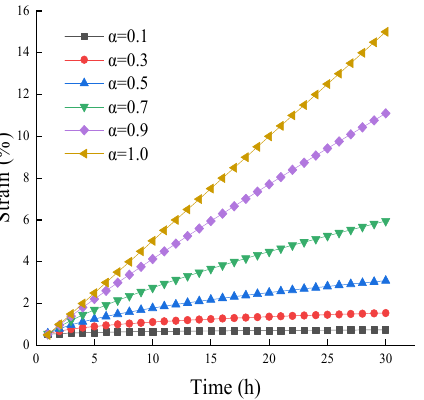
Figure 7. Creep strain under the case of fractional derivative orders characterized by the Abel dash- pot.